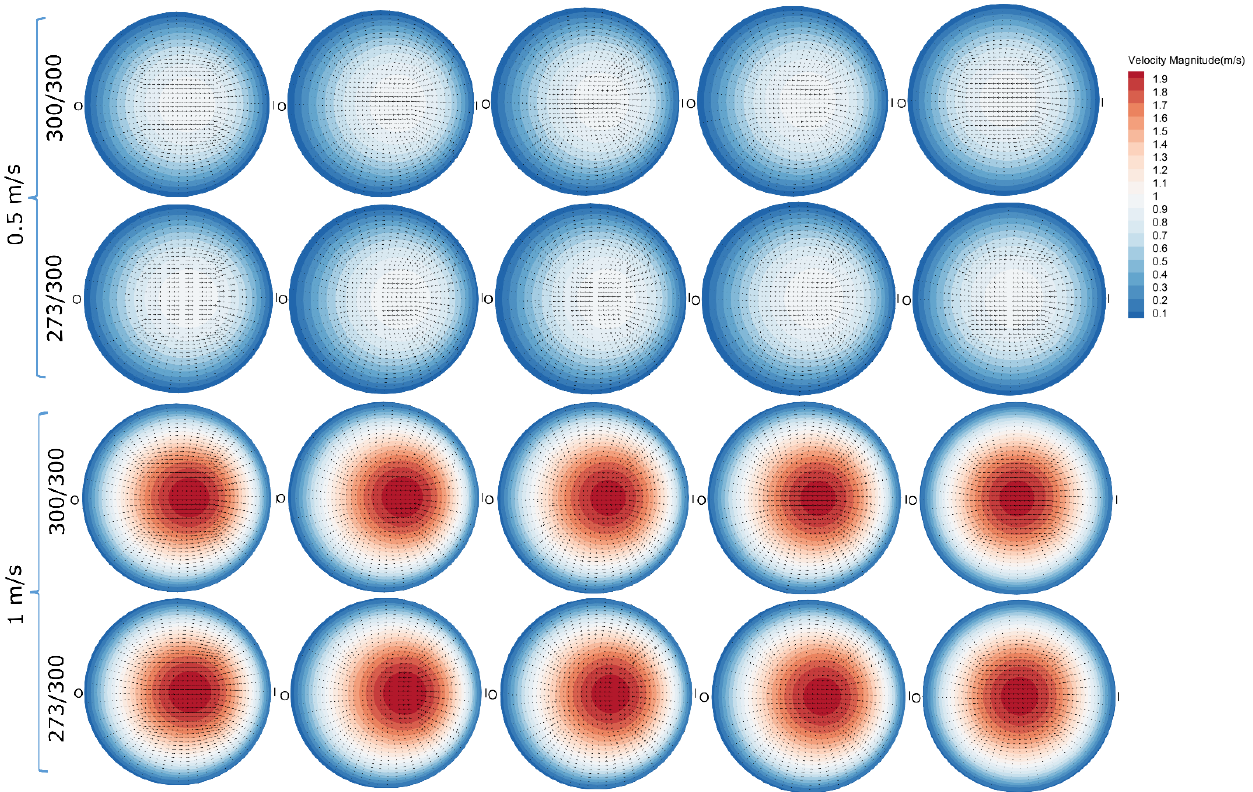
Figure 7. The velocity magnitude and the velocity vector arrows at the five sections of the U-shaped channel. The first row shows the data at the inlet velocity of 0.5 m/s with no temperature difference. The second row shows the results at the inlet velocity of 0.5 m/s but at the temperature conditions of 273 K on the wall and 300 K of the incoming fluid at the inlet. The third row shows the results at the inlet velocity of 1 m/s with no temperature difference. The fourth row shows the results at the inlet velocity of 1 m/s but at the temperature conditions of 273 K on the wall and 300 K of the incoming fluid at the inlet.